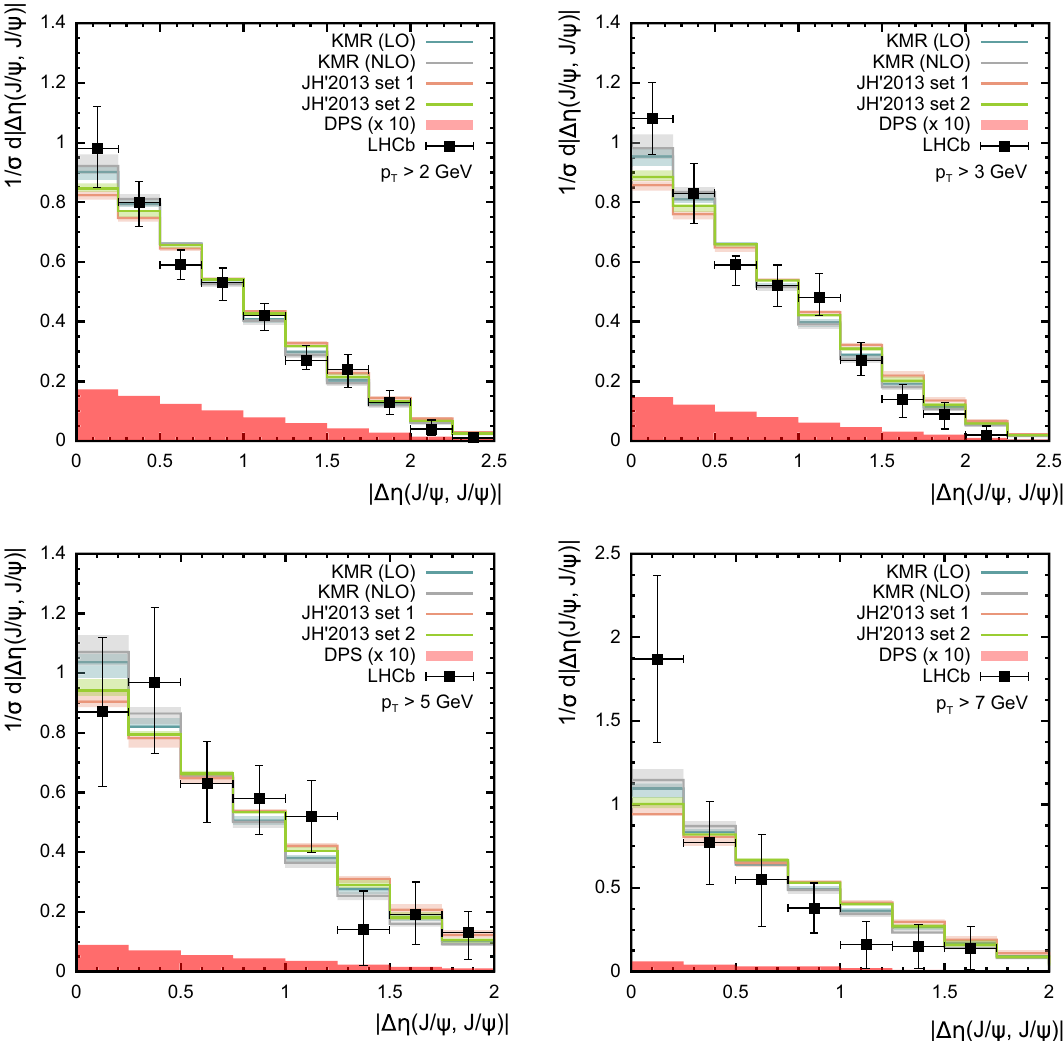
√ s = 8 TeV as a function of the difference in the